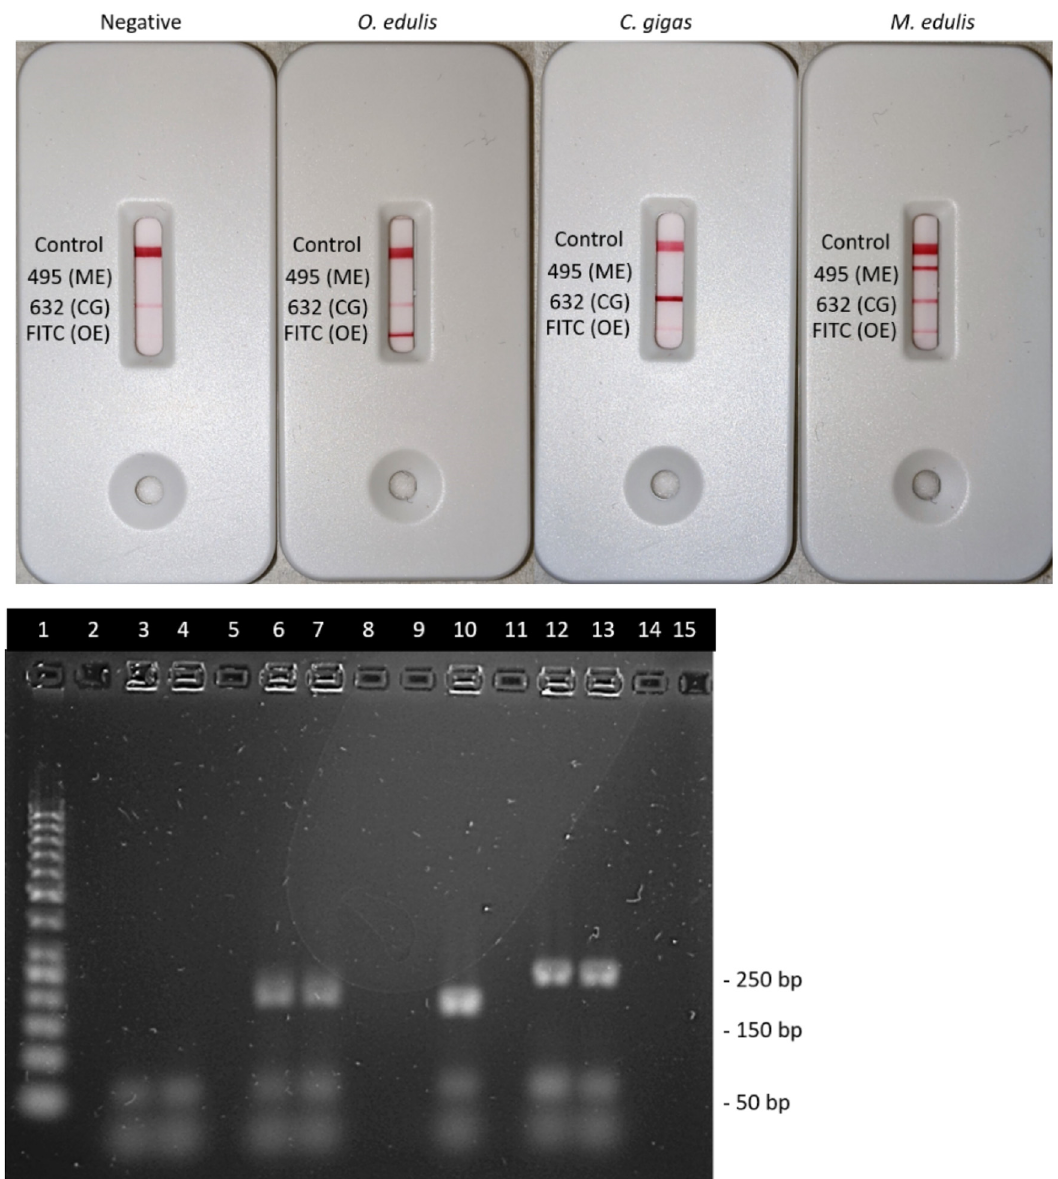
Fig. A1. Example of false-positive PCR-nucleic acid lateral fl ow immunoassay (NALFIA) with a combination of three primer pairs and one DNA template of Ostrea edulis , Crassostrea gigas , and Mytilus edulis . The NALFIA for the negative control shows a light red band for C. gigas although non-DNA template was present and the 3% agarose gel electrophoresis shows no band at the expected position for C. gigas at 174 bp. The NALFIA for O. edulis shows false-positive result for C. gigas and the NALFIA for C. gigas shows a false-positive result for O. edulis , respectively. Likewise, these two false-positive results don ́ t show an expected band in the gel electrophoresis on lane 6 and lane 7 at 174 bp for C. gigas and on lane 10 at 191 bp for O. edulis , respectively. The NALFIA for M. edulis shows false-positive results for O. edulis and C. gigas , but the gel electrophoresis only shows expected bands for M. edulis on lane 12 and lane 13.